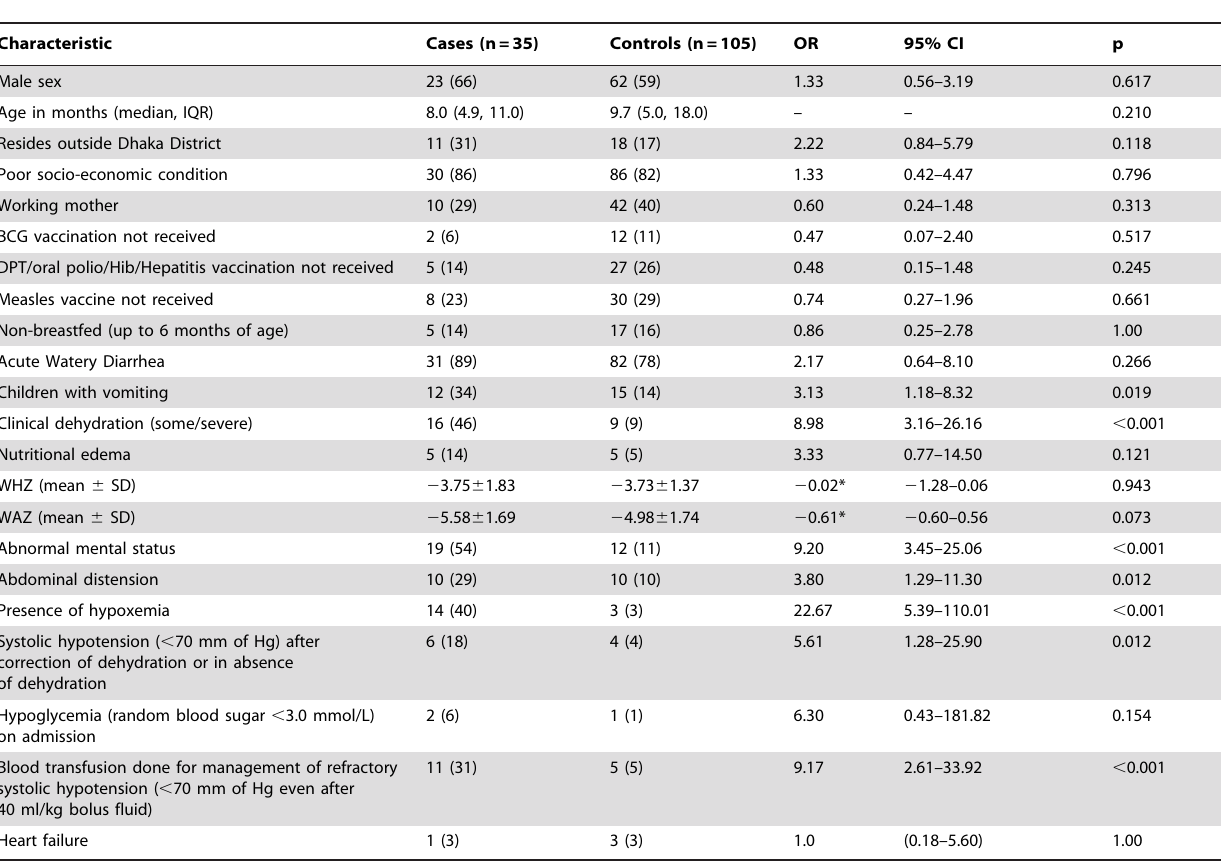
Figures represent n (%), unless specified. OR: odds ratio. CI: confidence interval. IQR: inter-quartile range.BCG: Bacillus Calmette-Guerin. DPT: Diphtheria, Pertusis and Tetanus. Hib: Hemophilus Influenza type B. SD: standard deviation. WHZ: weight for height z score; WAZ: weight for age z score; SpO 2: transcutaneously measured blood oxygen concentration; *mean